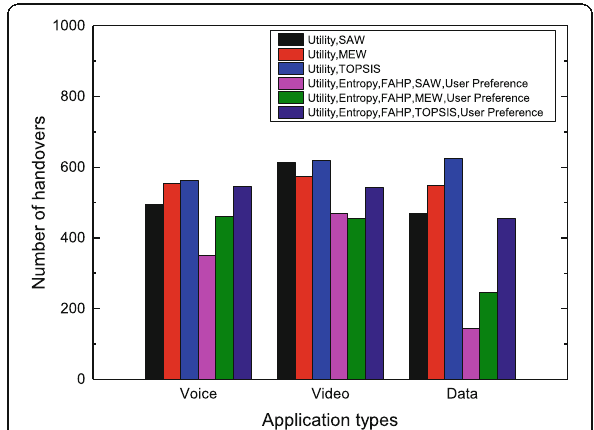
Fig. 16 Number of network handovers under different